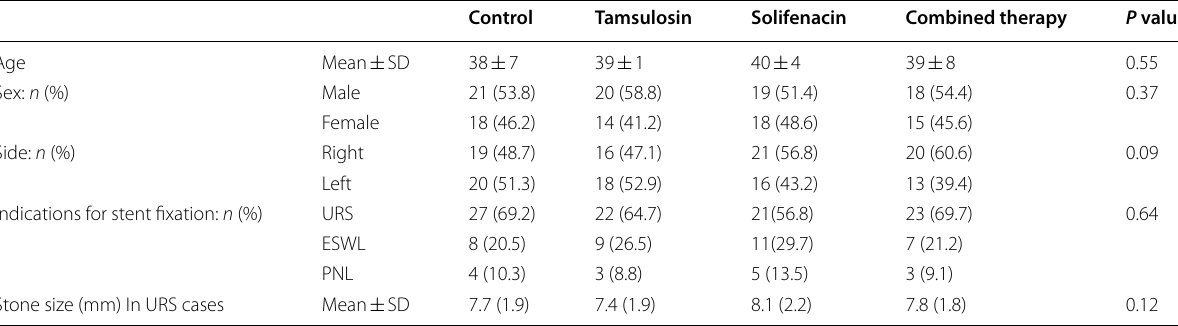
Table 1 Patients